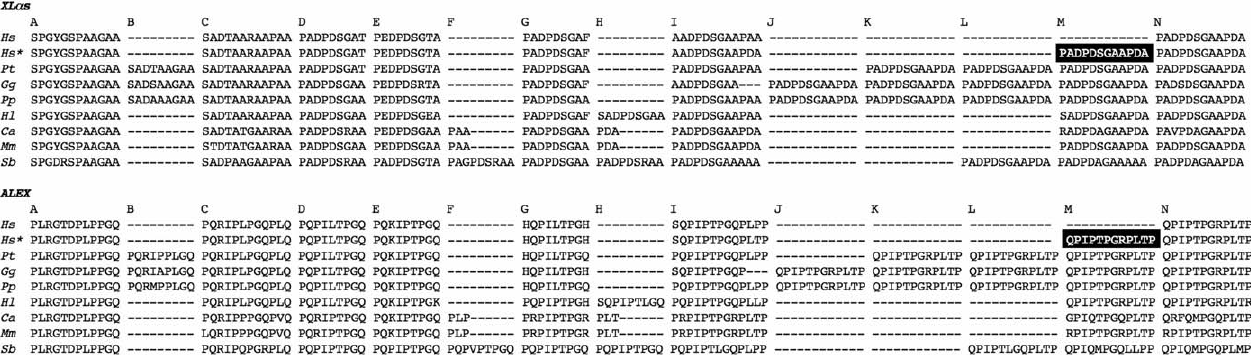
Figure 1. Alignment of Internal Repeat Region in XL a s and ALEX Polypeptides Black boxes highlight the position of the disease-linked repeat in the 14-unit human allele (Hs*) . Sequences upstream and downstream of the shown region can be aligned unambiguously. Species abbreviations as follows: Hs, Homo sapiens (human); Pt, Pan troglodytes (chimpanzee); Gg, Gorilla gorilla (gorilla); Pp, Pongo pygmaeus (orangutan); Hl, Hylobates lar (gibbon); Ca, Colobus angolensis (colobus monkey); Mm, Macaca mulatta (macaque); Sb, Saimiri boliviensis (squirrel monkey). DOI: